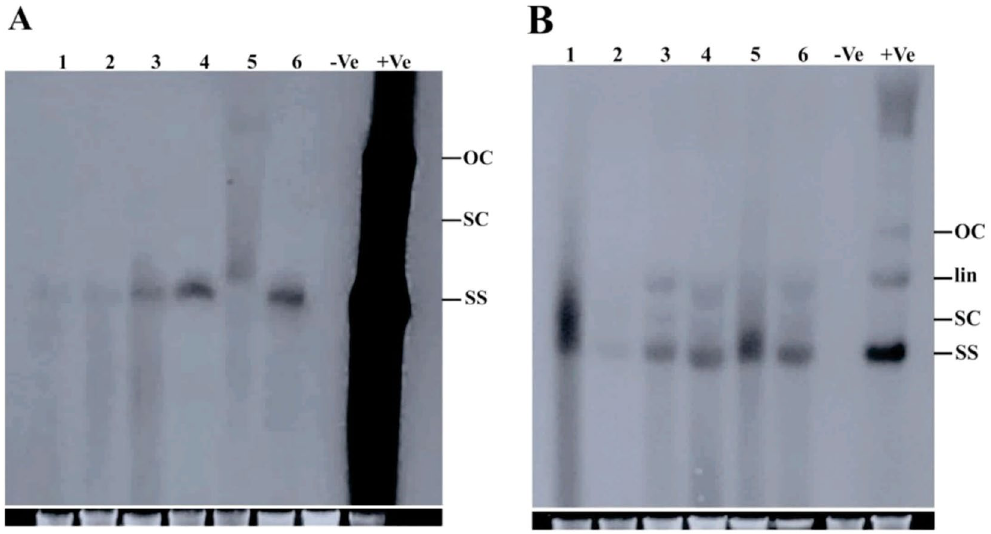
Figure 6. Southern blot hybridization analysis of begomovirus and betasatellite. ( A ) Southern blot hybridization with begomovirus probe. Genomic DNA from cotton samples were loaded in lane 1–6 respectively. Agro-infiltrated plants genomic DNA was used as positive control and healthy plant genomic DNA as negative control represented as + Ve and − Ve, loaded in lane 7 and 8 respectively. ( B ) Southern blot with betasatellite probe. Genomic DNA from cotton samples were loaded in lane 1–6 respectively. Positive control and negative control represented as + Ve and − Ve, loaded in lane 7 and 8 respectively. The different replicative forms of viral DNA are shown as open circular (oc), linear (lin), supercoiled (sc) and single stranded